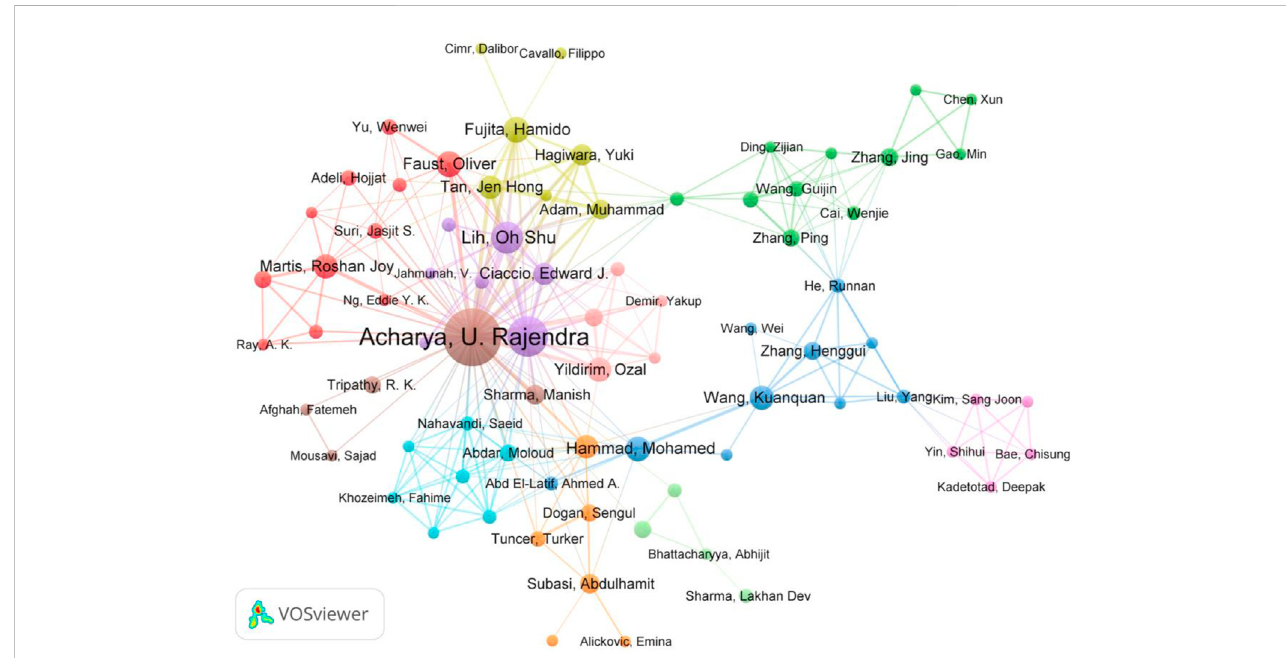
FIGURE 5 The visualization map of international co-authoring authors network using VOSviewer.